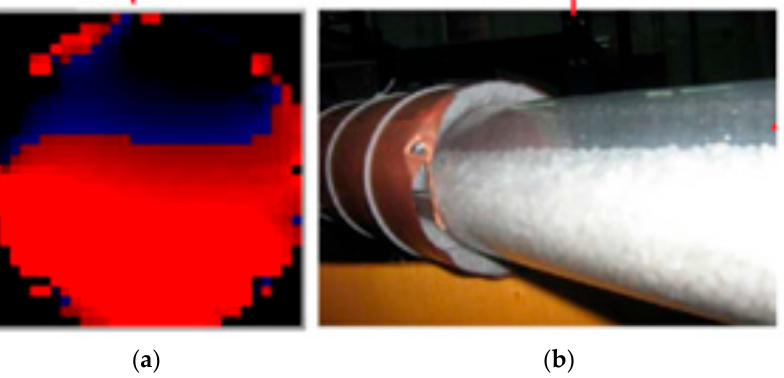
Figure 5. Reconstructed ECT image ( a ) and the photography that presents the material inside the pipe. ( b ) The red color shows the material inside the pipe, and the black color represents an empty part of the pipe. On the right hand, ( b ) the image of the pipe section is presented.